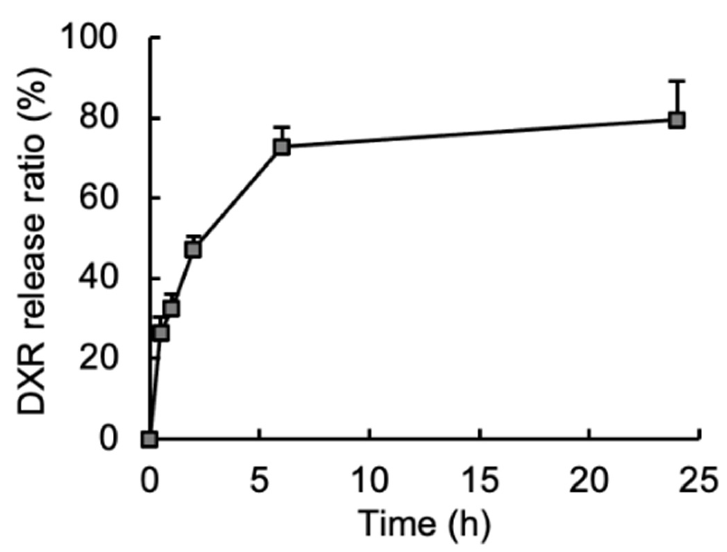
Figure 2. In vitro DXR release from DXR/CM-NFBC in peritoneal wash fluid. DXR/CM-NFBC (500 µL) was centrifuged and the supernatant was discarded. Peritoneal wash fluid was then added dropwise onto the DXR/CM-NFBC precipitates to a total volume of 1 mL. At selected time points post-incubation at 37 °C (0.5, 1, 2, 6 and 24 h), 100 µL of the supernatant was collected, and the DXR content was analyzed via HPLC. Data represent the mean ± SD ( n = 6).